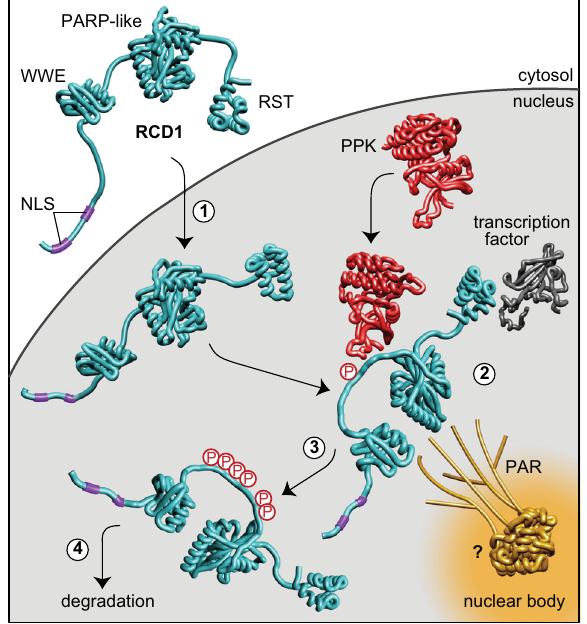
Fig. 5 A model for the regulation of nuclear RCD1 function by PAR binding and phosphorylation by PPKs. (1) RCD1 enters the nucleus by means of its bipartite N-terminal NLS sequence. In the nucleus, RCD1 interacts with PPKs, with diverse transcription factors and with PAR (2). PAR recruits RCD1 to NBs of yet uncharacterized nature. Unknown PARylated proteins involved in RCD1 recruitment are labeled with a question mark. RCD1 is phosphorylated by PPKs at multiple sites in IDR2 (3), which affects RCD1 functions and facilitates RCD1 degradation (4). RCD1 structure was predicted in RaptorX (http://raptorx.uchicago.edu/). Structural model of the WWE domain is based on mouse RNF146 (2RSF), structures of RCD1 PARP-like (5NGO) 12 and RST (5N9Q) 1 domains have been reported. Terminal and inter-domain regions of RCD1 are not drawn to